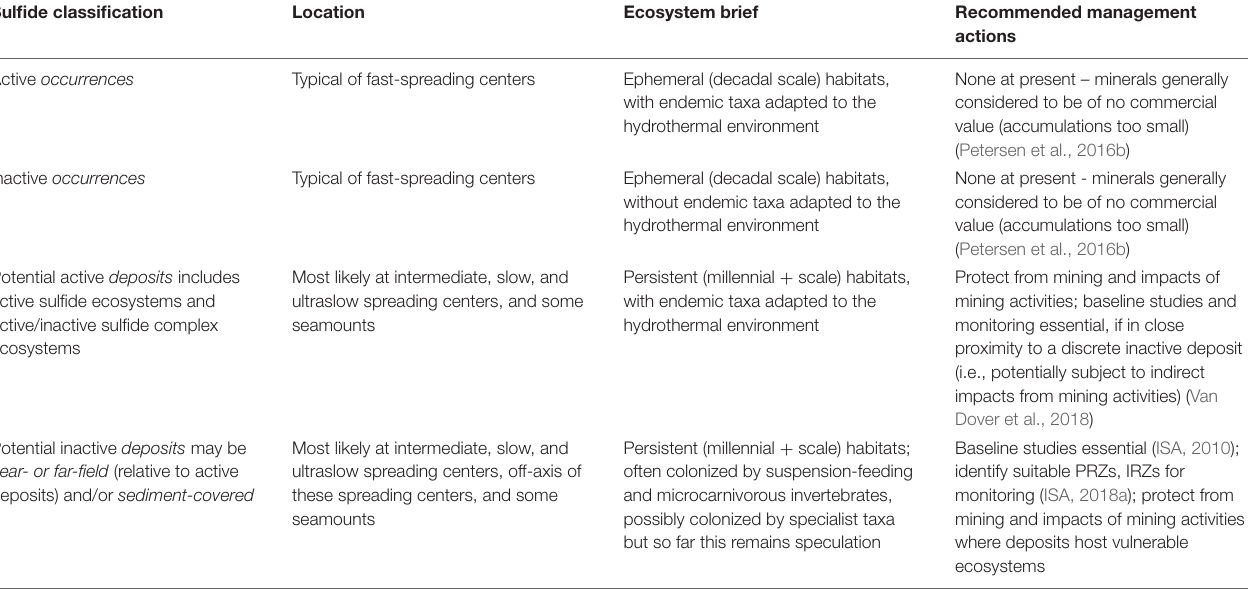
TABLE 1 | The continuum of massive sulfide systems (occurrences and deposits; see Terminology), with environmental management recommendations for consideration within the Area Beyond National